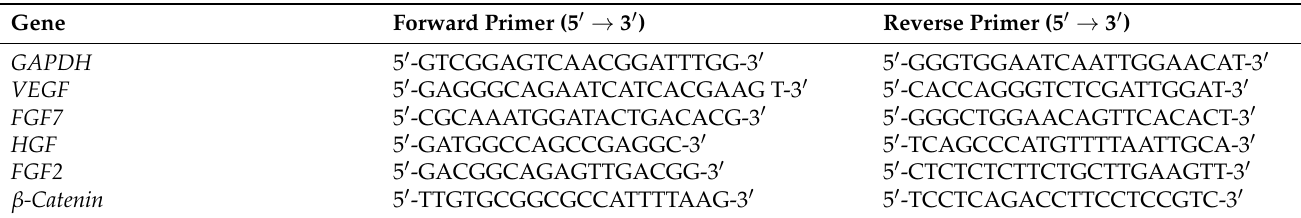
Table 1. Primers used in quantitative reverse transcription polymerase chain